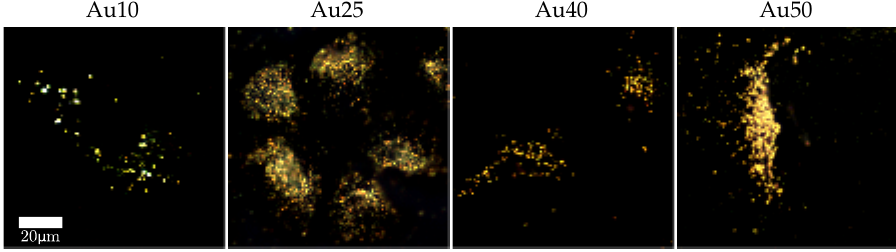
Figure 5. Dark-field images of lung cancer cells (A549) incubated with different sized AuNRs for 24h at a concentration of 20 µ